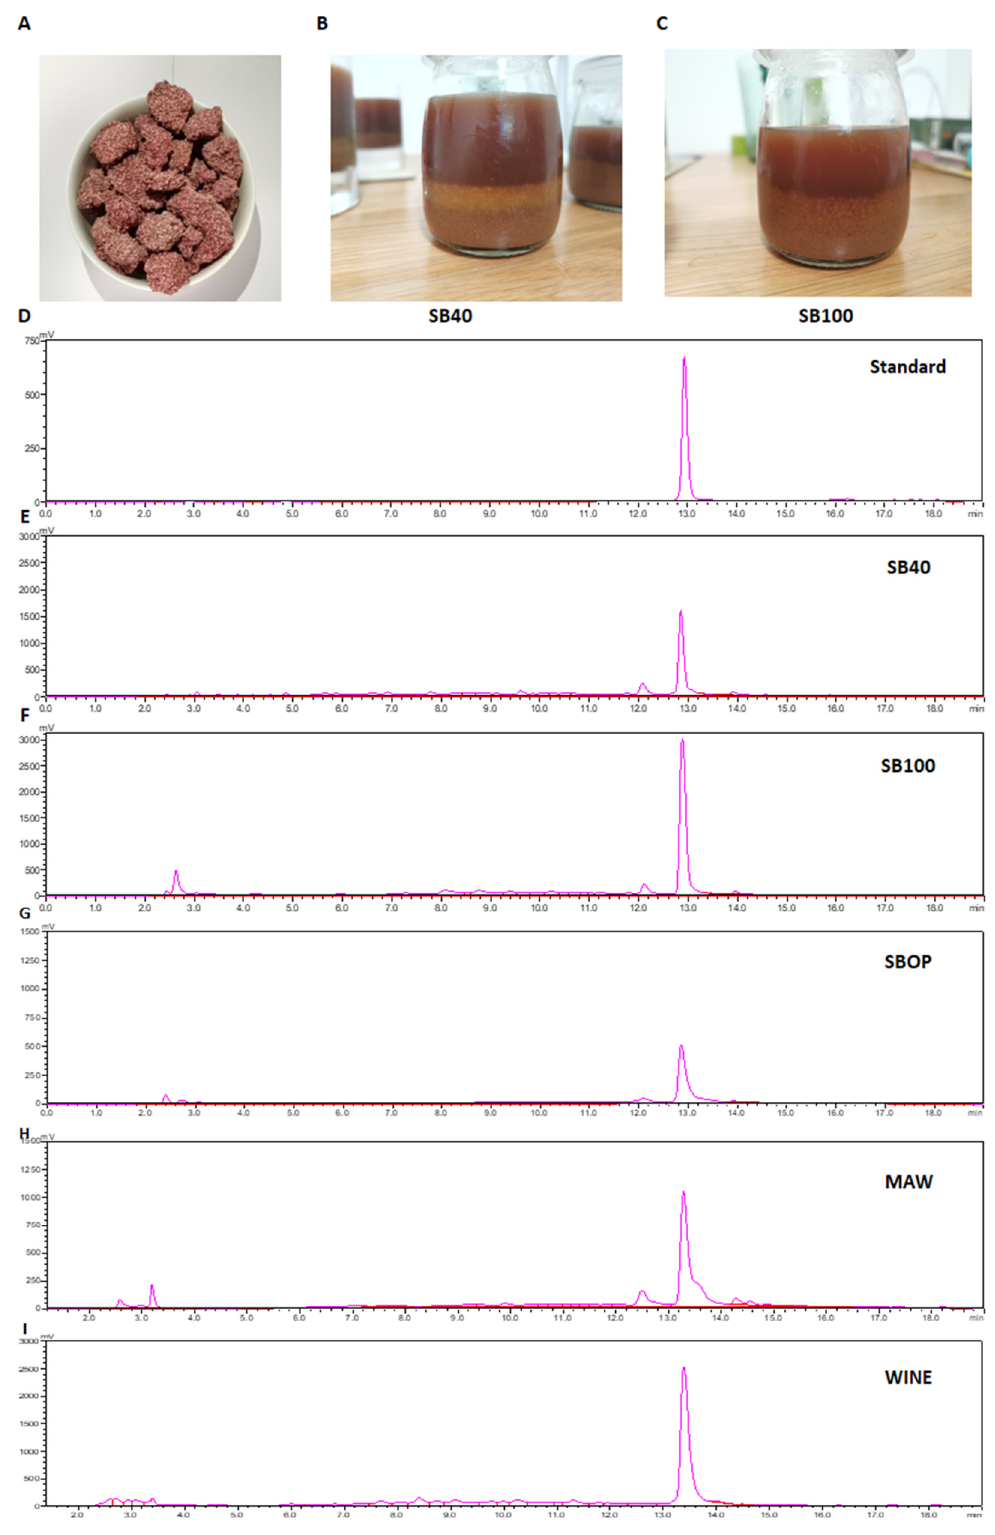
Figure 5. The pomace sample, extraction solution and the HPLC analysis. ( A ), raspberry wine pomace; ( B ), the extraction solution under the condition of 1% NaHCO 3 , 40 °C, 1 h, and S/L ratio of 1:10 (SB40); ( C ), the extraction solution under the condition of 1% NaHCO 3 , 100 °C, 10 min, and S/L ratio of 1:10 (SB100); ( D ), the standard of ellagic acid; ( E ), the SB40 sample; ( F ), the SB100 sample; ( G ), the optimal condition of SBAE method (SBOP), which is 1.2% NaHCO 3 , 100 °C, 22 min, and S/L ratio of 1:93; ( H ), the MAW sample; ( I ), the raspberry wine sample.